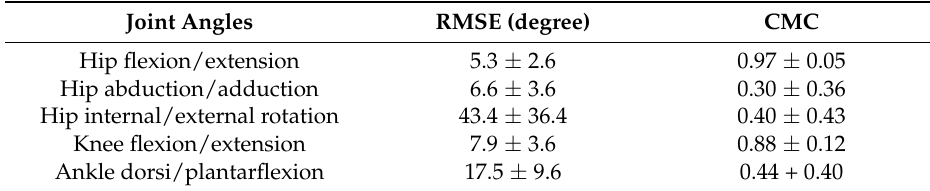
Figure 2. The average (±SD) hip, knee, and ankle angles during a gait cycle, across all walking trails in day 1 and day 2. Table 5. RMSE, CMC (±SD) between the joint angle trajectories calculated by Kinect in day 1 and day 2.